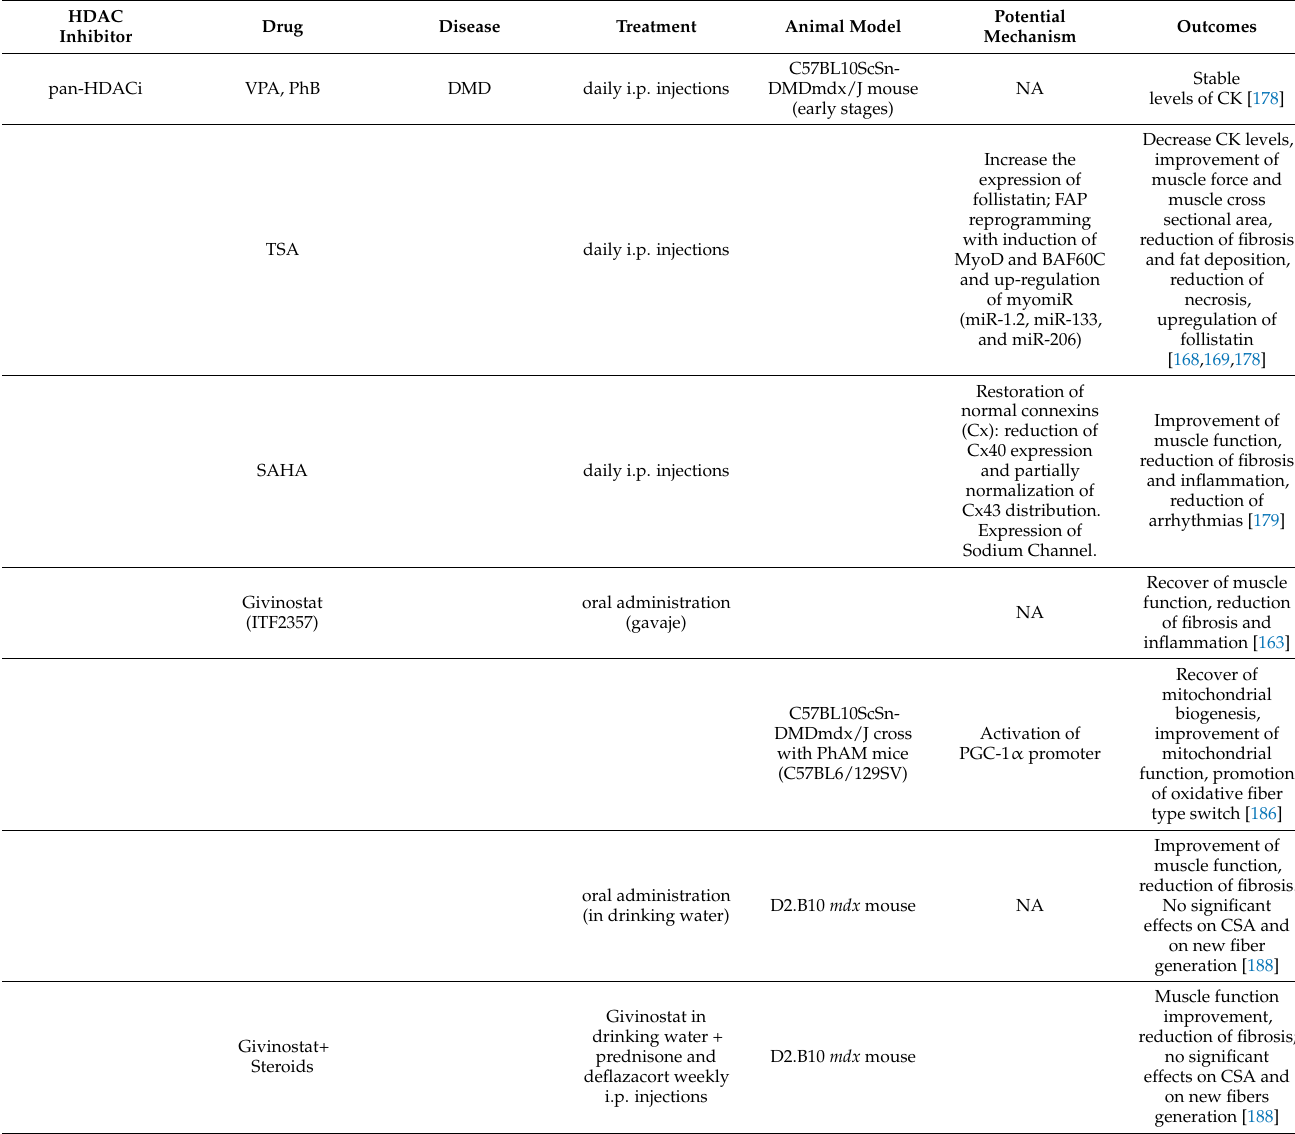
Table 2. Histone deacetylase inhibitors or activators in preclinical studies for the treatment of MDs. HDAC Inhibitor Drug Disease Treatment Animal Model